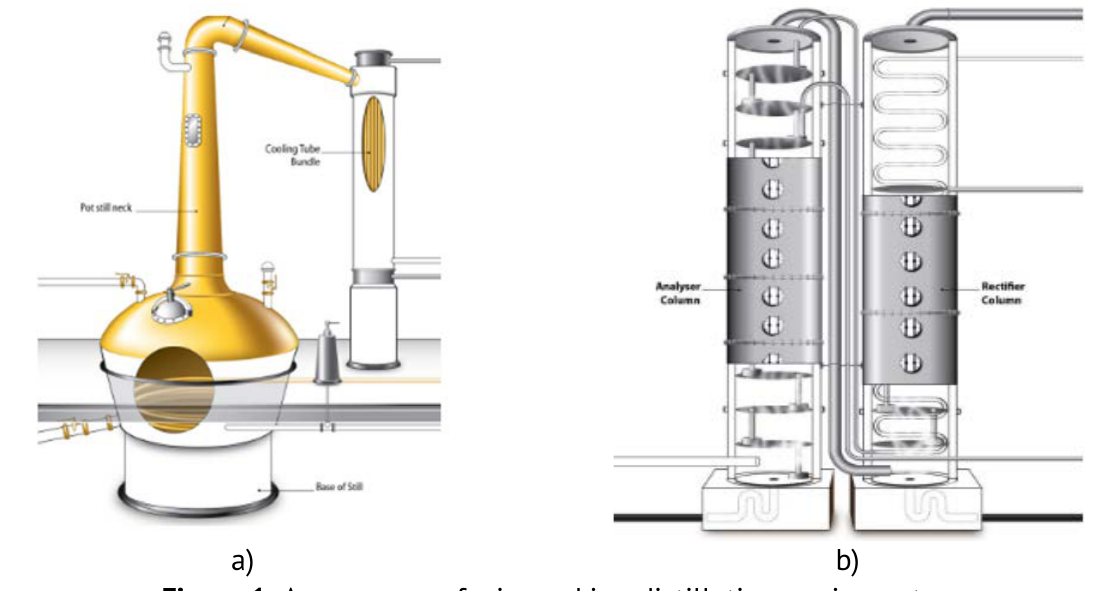
Figure 1. Appearance of winemaking distillation